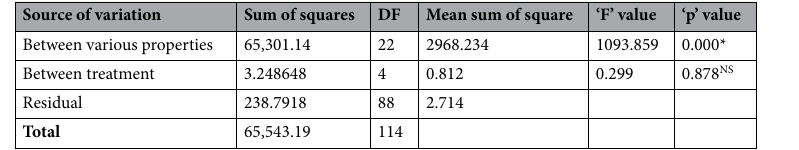
Source of variation Sum of squares DF Mean sum of square ‘F’ value ‘p’ value Between various properties 65,301.14 22 2968.234 1093.859 0.000* Between treatment 3.248648 4 0.812 0.299 0.878 NS Residual